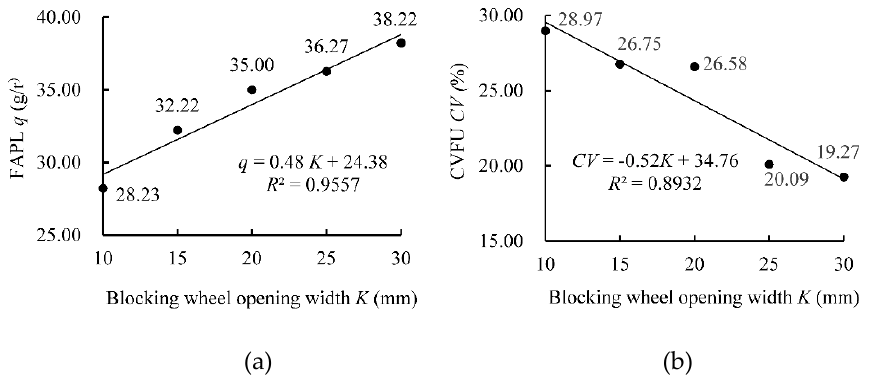
Figure 7. Effect of the blocking wheel opening width on the performance of fertilizer distributor. ( a ) Effect on fertilizer amount per lap (FAPL), ( b ) effect on coefficient of variation of fertilization uniformity (CVFU).